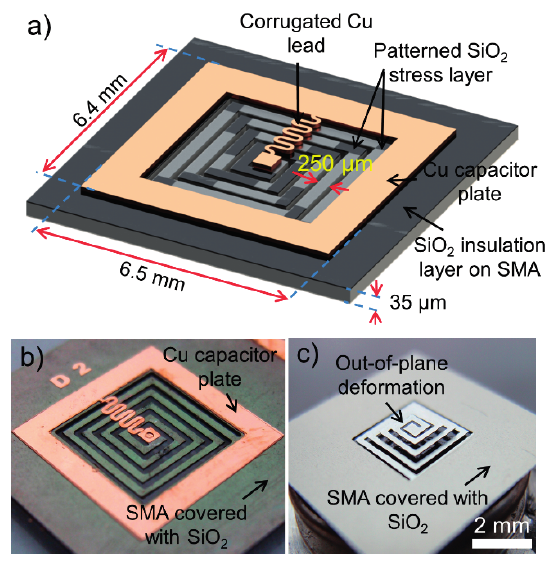
Figure 2. ( a ) Device design and structure (showing the backside of the device); ( b ) backside of fabricated device; ( c ) front side of fabricated device with out-of-plane